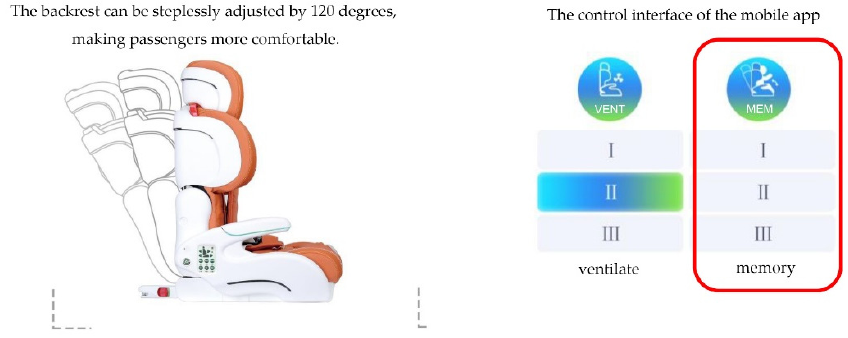
Figure 3. The 120-degree backrest has infinite adjustment and three memory positions.